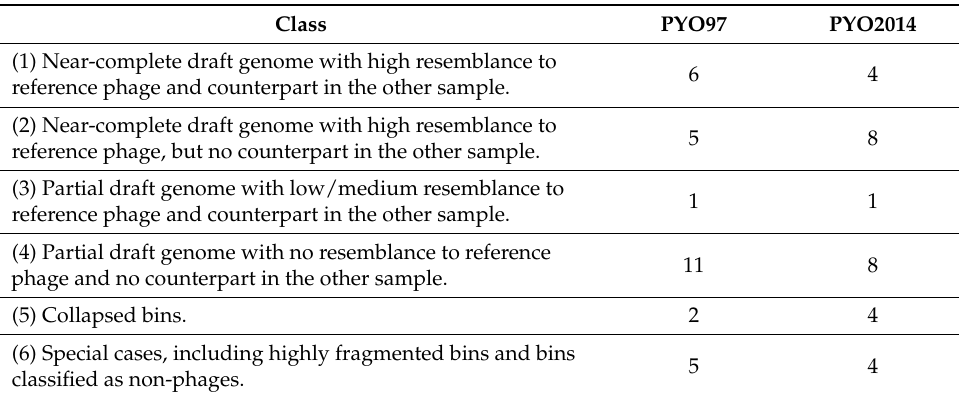
Table 7. Count of draft genomes/bins belonging to each